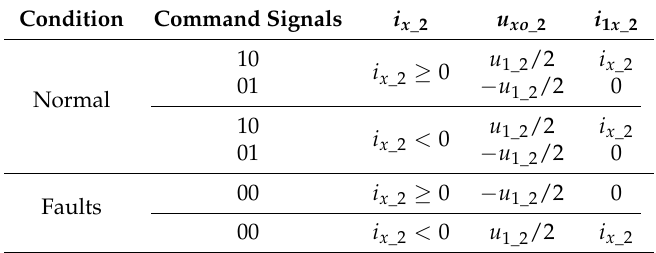
Table 1. Relationship between inputs and outputs of a single two-level